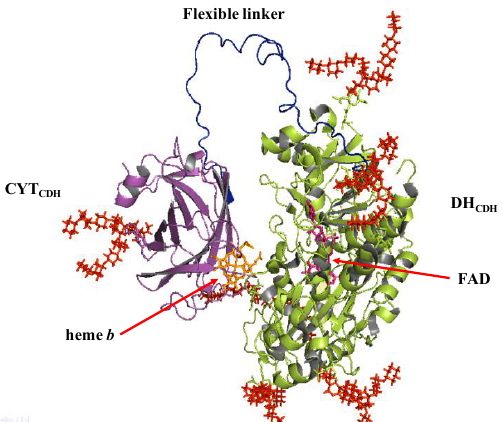
Figure 2. Schematic representation of cellobiose dehydrogenase (CDH): DH CDH domain is shown in green with the FAD cofactor in pink; CYT CDH domain in violet with heme b cofactor in orange; the flexible linker, in blue, is responsible for the modulation of internal electron transfer (IET); all the potential glycosylation sites are shown in red.